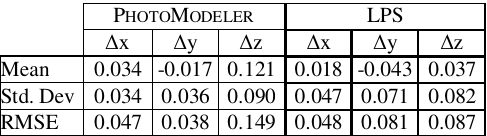
Table 4. Statistics of CPs residuals [m]